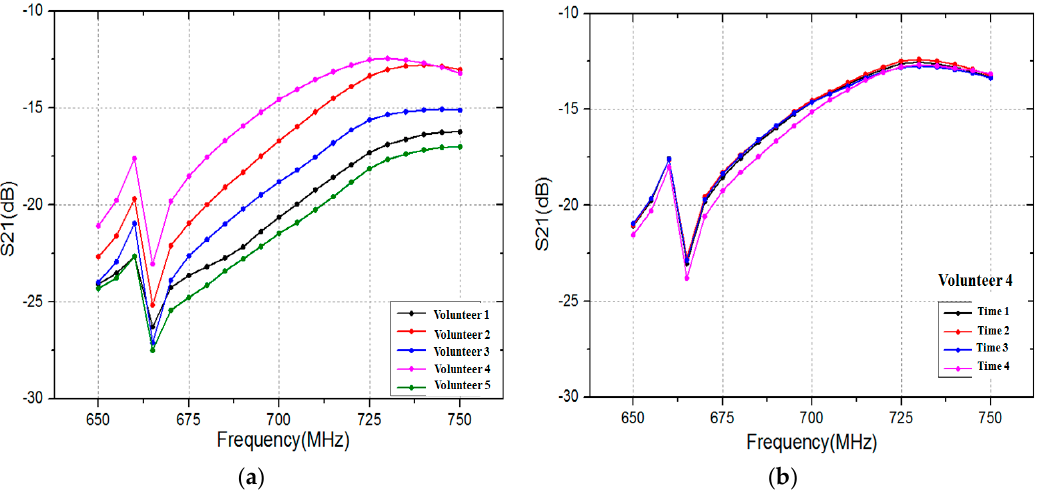
Figure 8. Transmission gain S21 in the frequency range 650 MHz to 750 MHz: ( a ) five volunteers at the same time; and ( b ) Volunteer 4 at four different times.